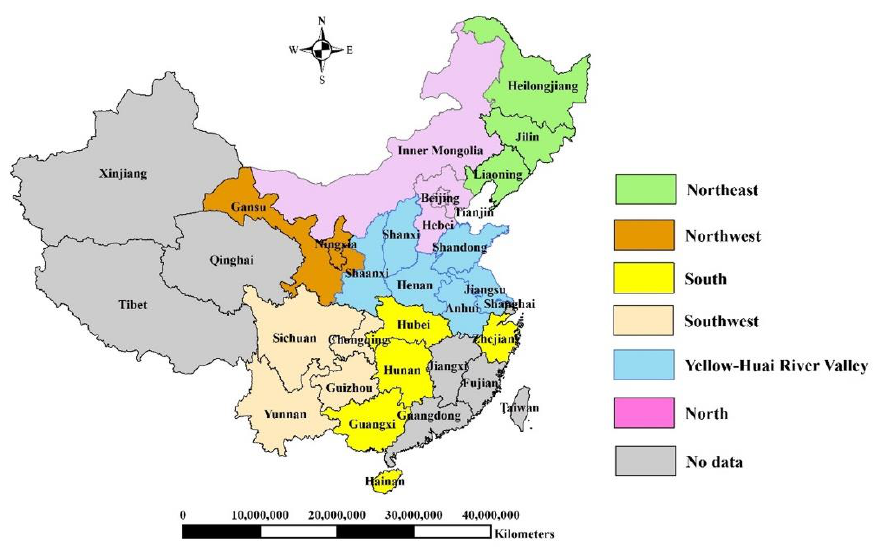
Figure 2. The division of six agroecological maize regions in this